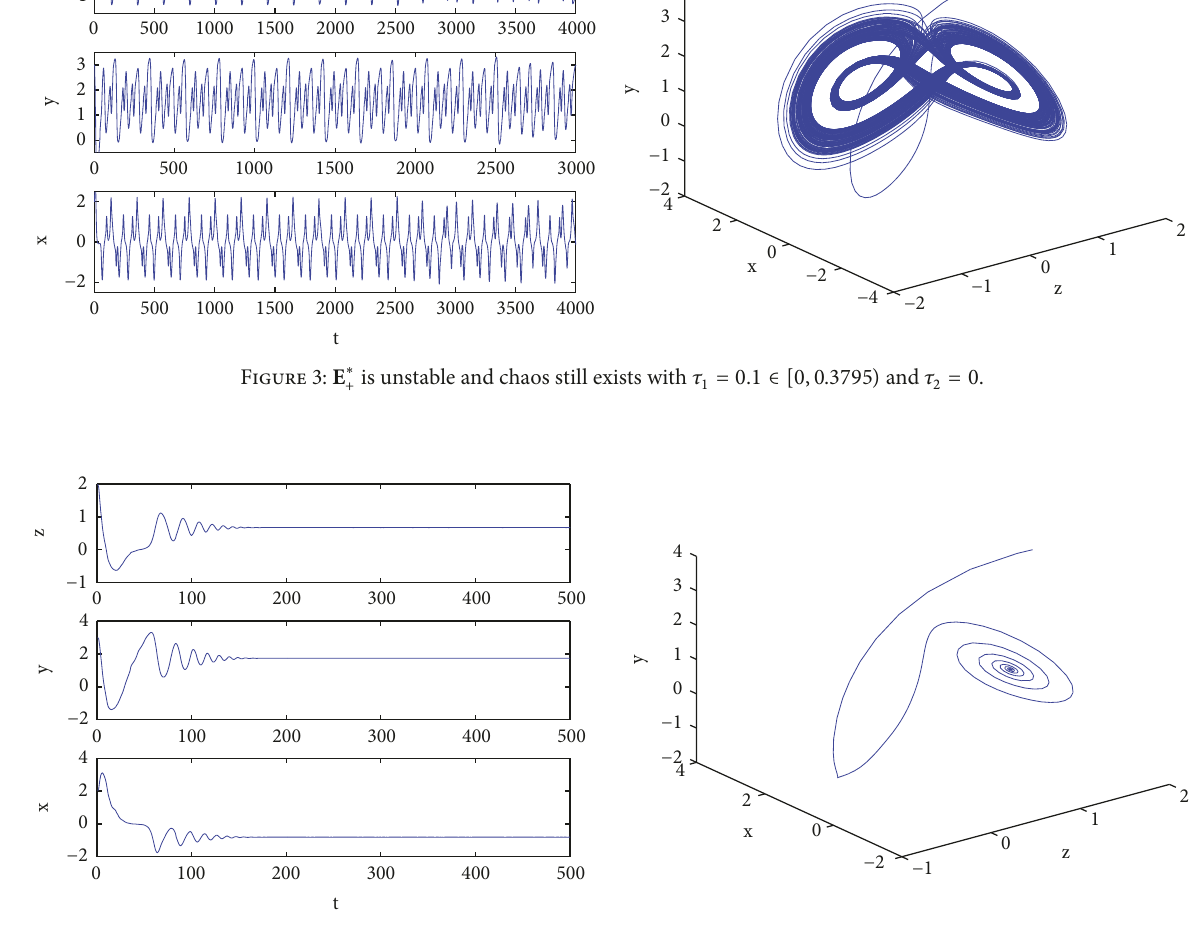
Figure 4: E ∗ + becomes stable and chaos disappears with 𝜏 1 = 0.8 ∈ (2.2945, 4.3572) and 𝜏 2 = 0 .